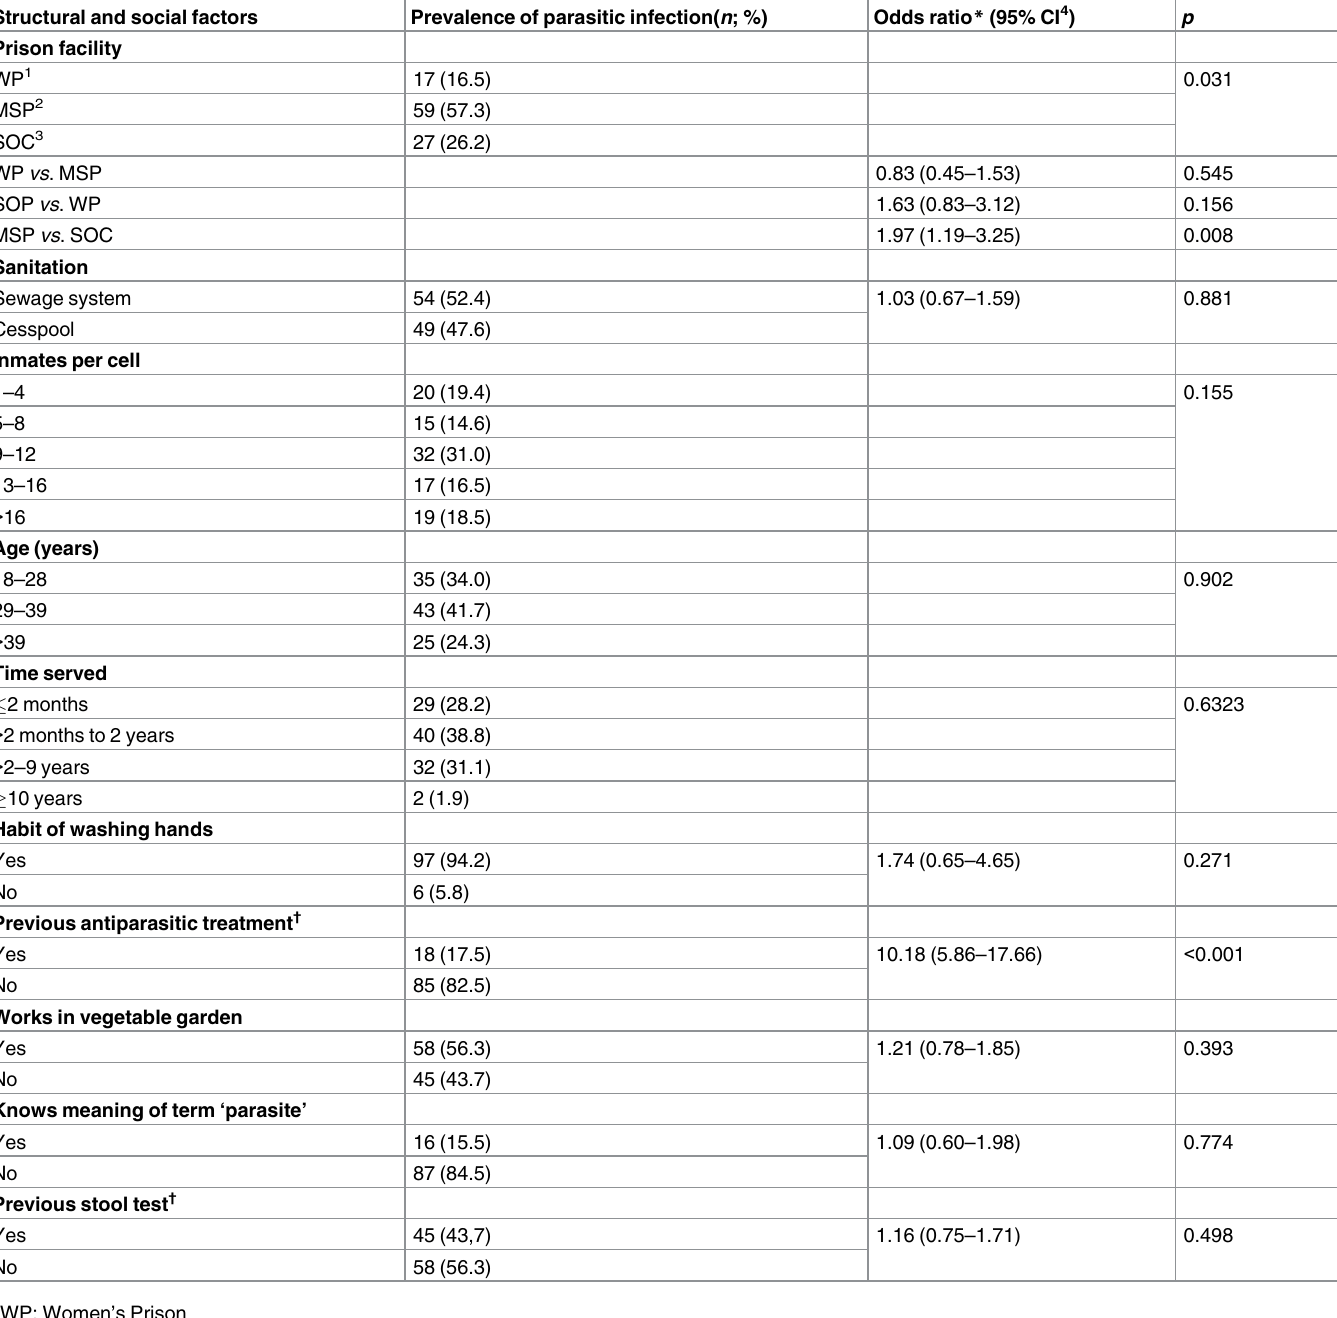
Table 4. Logistic regression analysis of structural, social, and behavioral factors associated with prevalence of intestinal parasitic infection among inmates. Mato Grosso do Sul, Midwest Brazil. Structural and social